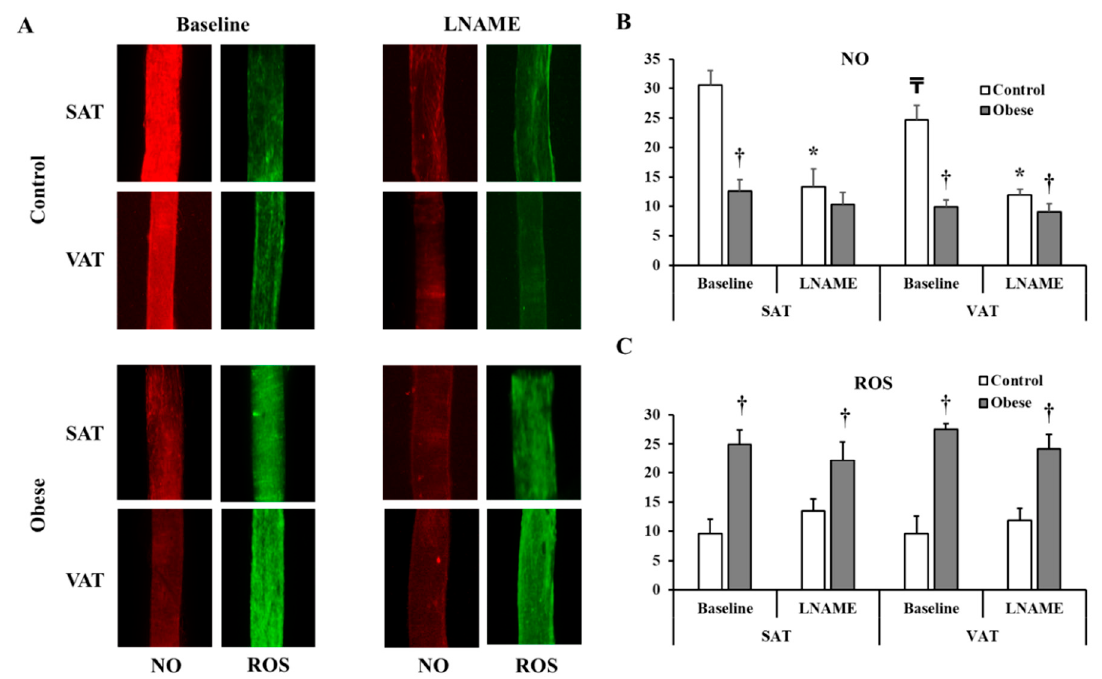
Figure 8. NO and Reactive Oxygen Species (ROS) production in isolated adipose tissue arterioles. ( A ): Representative images by fluorescence microscopy of NO (red fluorescence) and ROS (green fluorescence) generation at baseline conditions and after incubation with L-NAME in adipose tissue arterioles collected obese subjects ( n = 40) and non-obese controls ( n = 40). The charts present NO ( B ) and ROS ( C ) fluorescent signals that were measured and expressed in arbitrary units using NIH Image J software. All measures are represented as means± SE. * ( p < 0.05) for comparing L-NAME to baseline in each group, † ( p < 0.05) for comparing obese subjects with controls, and ₸ ( p < 0.05) for comparing SAT and VAT arterioles in each treatment condition.